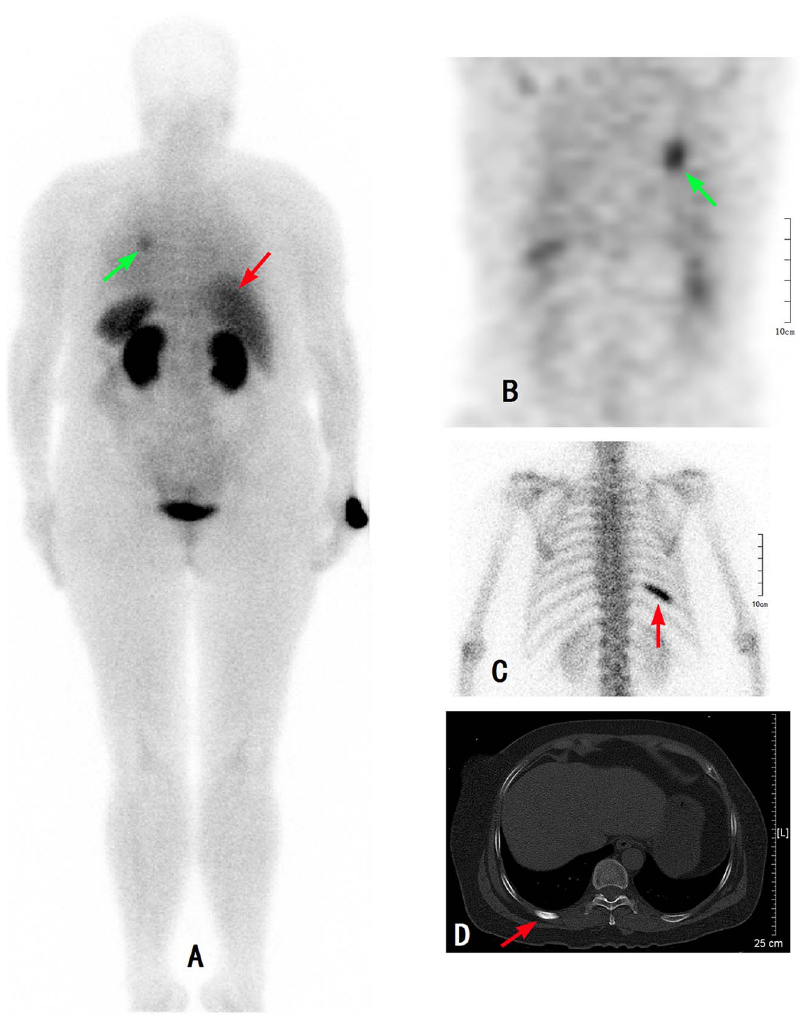
Figure 1. Comparison of 99m Tc-3PRGD2 SPECT, 99m Tc-MDP bone scan (posterior), and CT scan in a 62 year-old woman with left upper lung adenocarcinoma (green arrow) and costal metastasis (red arrow). A: 99m Tc -3PRGD2 WB( + ), B: 99m Tc -3PRGD2 SPECT ( + ), C: 99m Tc -MDP bone scan ( + ), D: CT ( + ). WB: whole body.